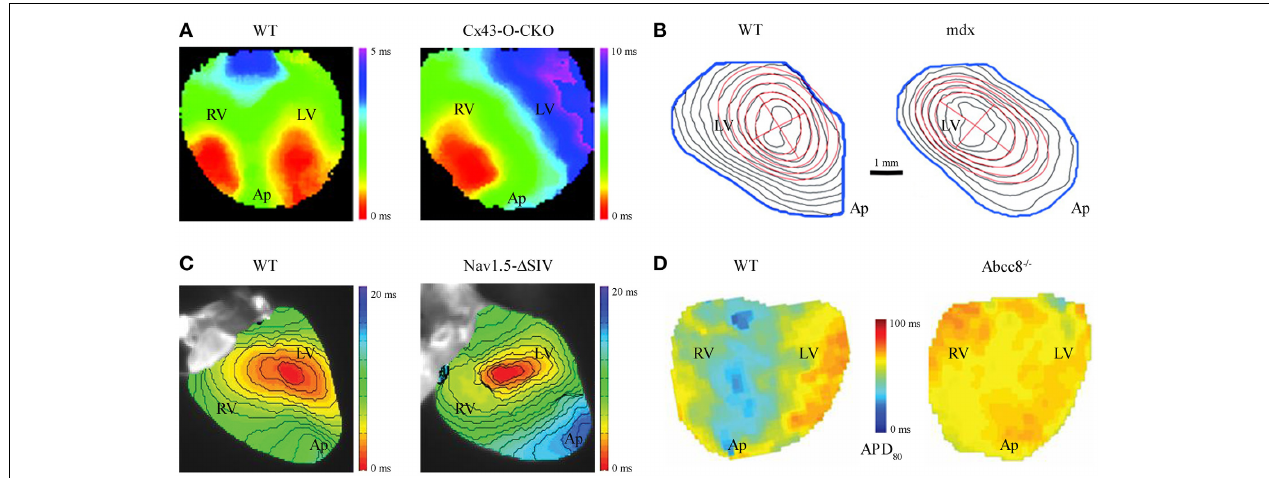
FIGURE 1 | Altered impulse propagation characterized by VSDI in transgenic mouse hearts. (A) Epicardial activation during spontaneous sinus rhythm in wild-type (WT) vs. cardiac specific Cx43 knockout mouse hearts, the latter a model of gradual loss (Cx43-O-CKO). Whereas WT hearts typically show 2 distinct sites of AP activation (“breakthroughs”) each for the left (LV) and right (RV) ventricle as seen on the anterior heart surface, Cx43-O-CKO mouse hearts show aberrant activation patterns (e.g., only one epicardial breakthrough or multiple fragmented sites of AP activation) leading to overall reduced transversal CV (WT 0.40 ± 0.02 vs. Cx-O-CKO 0.21 ± 0.02 m/s; Figure reproduced from Morley et al., 2005, Copyright 2005 National Academy of Sciences, U.S.A.). (B) Isochrone maps at 0.5ms resolution in WT vs. dystrophin-deficient mdx hearts show electrical activation delay during LV pacing at 100ms cycle length (red cross indicates epicardial pacing site at the apparent LV center). CV in mdx hearts is significantly reduced, particularly in the transversal direction relative to the main fiber orientation (WT 0.48 ± 0.03 vs. mdx 0.35 ± 0.07 m/s), and apparent through denser isochrone fits (red ellipses) due to selective loss of Nav1.5 channels at the lateral surface membrane in myocytes (Figure reproduced from Petitprez et al., 2011 with